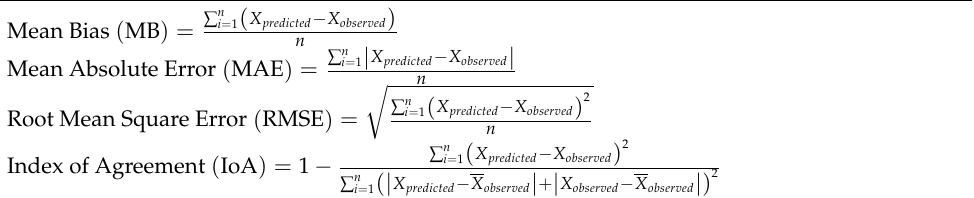
Table 1. Statistical Measures.